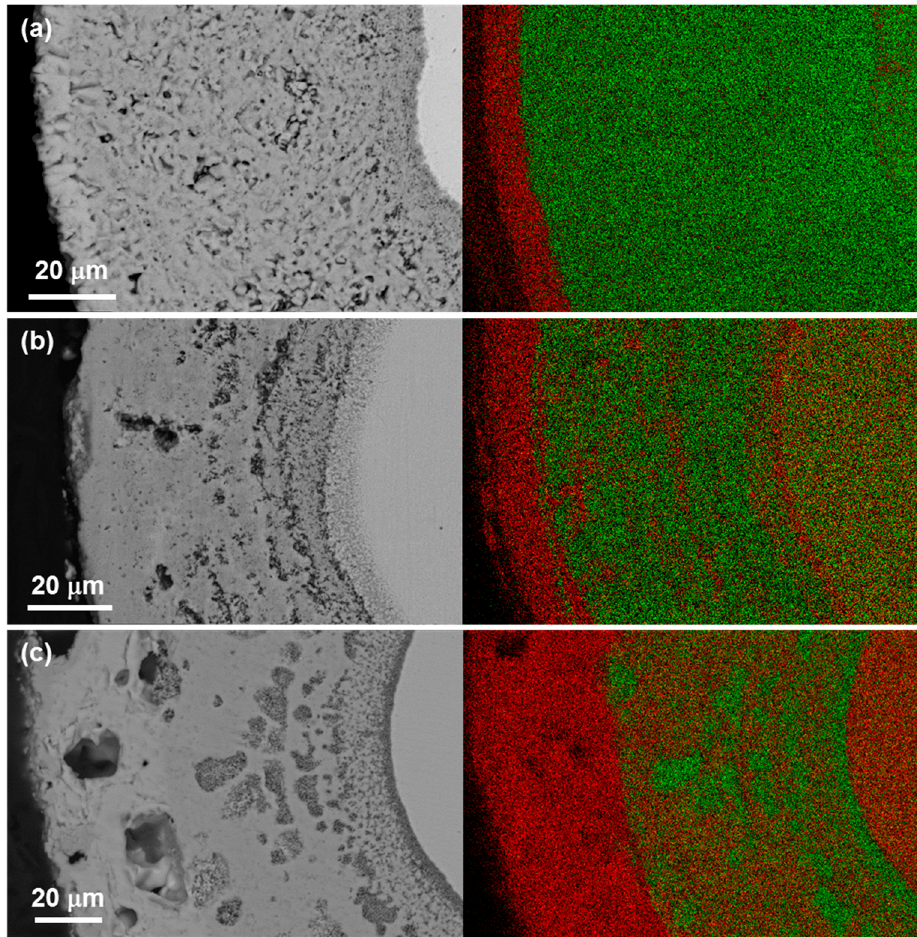
Figure 4. Backscattered electron micrographs ( left ) and elemental maps ( right ) of the cross section of the oxidized Cu-65Ni ( a ); Cu-44Ni ( b ) and Cu-23Ni ( c ) wires. In the elemental maps, red and green dots indicate Cu and Ni, respectively.